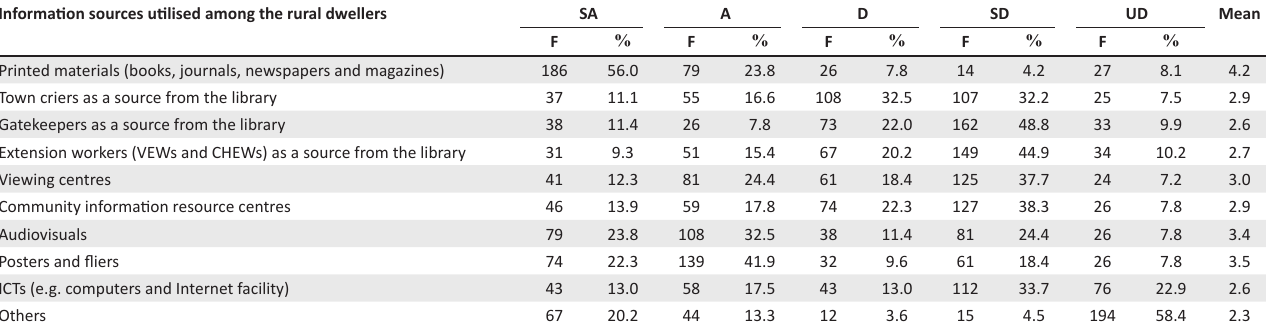
Table 13: Opinions of the library users on the forms of information sources utilised among rural dwellers from public libraries ( N = 332). Information sources utilised among the rural dwellers SA